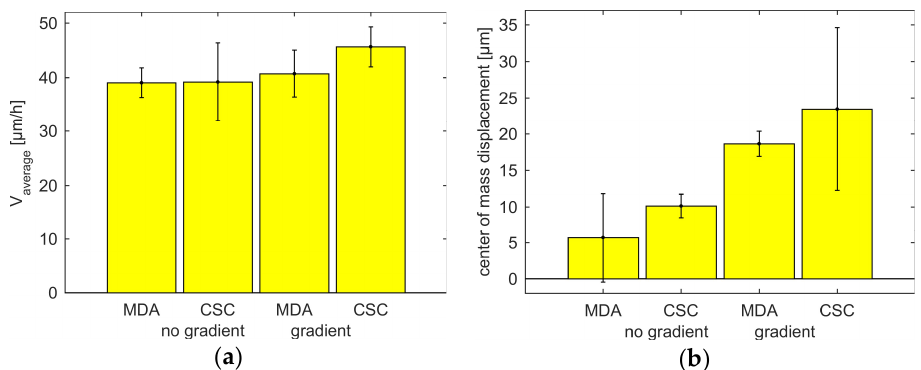
Figure A2. Additional migration properties of MDA-MB-231 cells and their CSC population, averaged over three samples per condition: ( a ) The average migration velocities and ( b ) the center of mass displacements, defined as the total displacement of the average cell position of all 50 tracked cells.